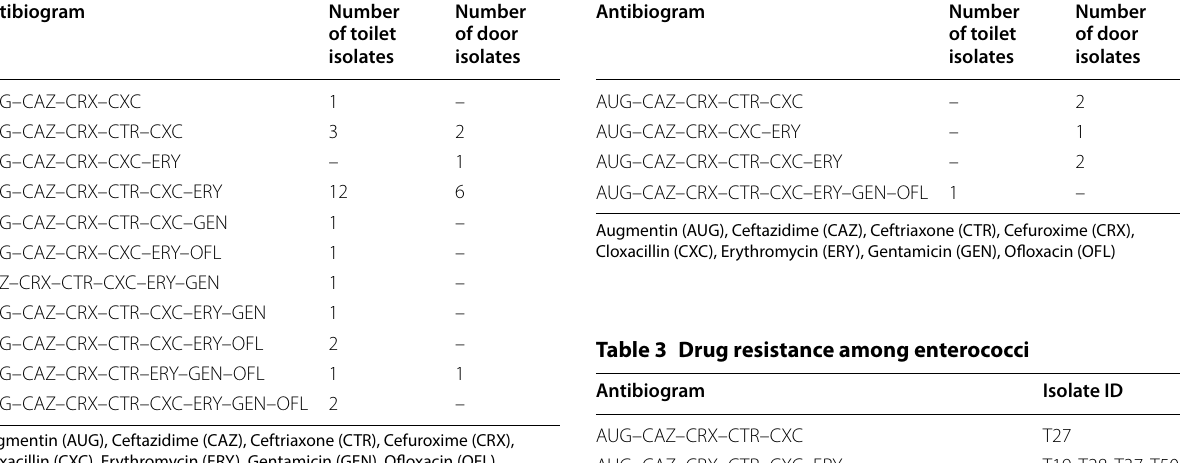
Table 1 Antibiotic resistance patterns and occurrence for toilet handles and office door knob isolates